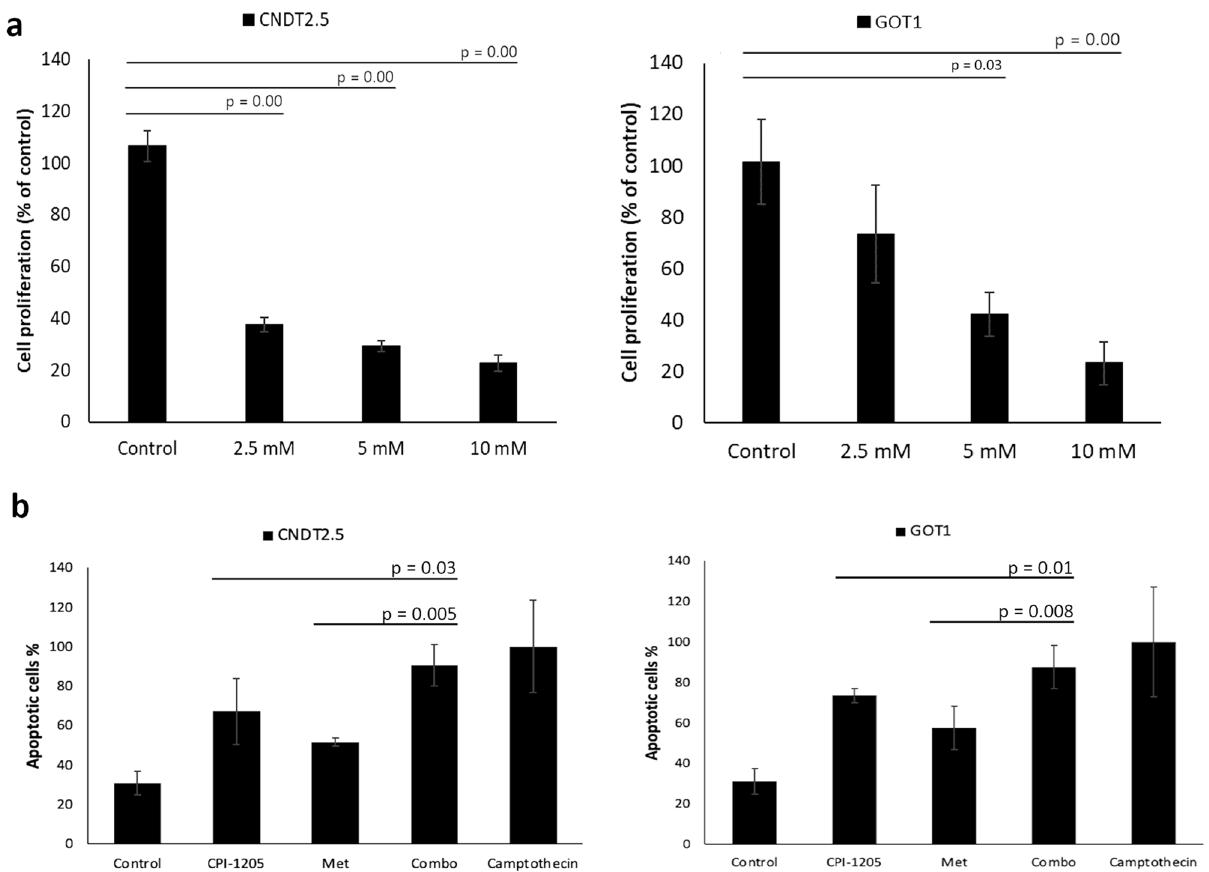
Figure 6. Metformin treatment reduced proliferation and, in combination with CPI-1205, induced apoptosis in SI-NET cells. ( a ) Cell proliferation was determined in CNDT2.5 and GOT1 cells after 48 and 72 h, respectively. ( b ) CNDT2.5 and GOT1 cells were treated with CPI-1205 (200 μM), metformin (Met) (10 mM), or a combination of both (Combo), followed by apoptosis assay. Data shown are means ± SD of